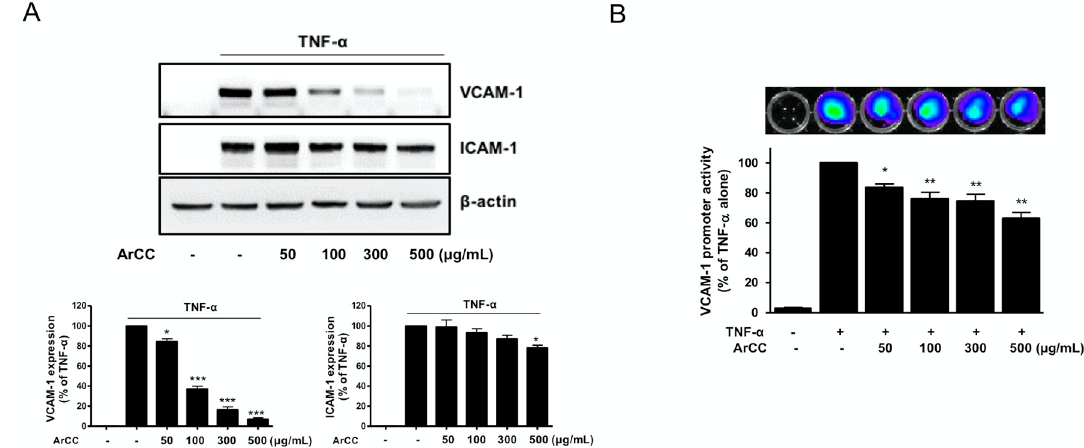
Figure 2. ArCC treatment suppresses adhesion molecule expression and transcriptional activation of vascular cell adhesion molecule-1 (VCAM-1) in TNF- α -stimulated human umbilical vein endothelial cells (HUVEC). ( A ) Immunoblotting for VCAM-1 and intercellular adhesion molecule-1 (ICAM-1) using lysates from tumor necrosis factor(TNF)- α -stimulated HUVECs treated with ArCC at the indicated concentrations. β -actin was used as the loading control. Relative changes in VCAM-1 (left) and ICAM-1 (right) expression levels were calculated based on densitometric scanning of each band. ( B ) Effects of ArCC on transcription of VCAM-1 were measured via luciferase reporter assay. Human embryonic kidney (HEK) 293T/VCAM-1-luc cells (4 × 10 4 cells/well) were plated in a black, 96-well plate, followed by treatment with various concentrations (0 to 500 µ g/mL) of ArCC, followed by stimulation with TNF- α for 6 h. The bioluminescent images were acquired following the addition of 150 µ g/mL D -luciferin substrate (upper). The luciferase activity, in units of total flux (p/s = photons/second) was quantified using an IVIS ® Lumina XRMS (X-ray multi-species optical imaging system) and analyzed by Living Image Software 4.4 (PerkinElmer) (lower). Values are expressed as mean ± SEM ( n = 3). * p < 0.05, ** p < 0.01, *** p < 0.001, compared with TNF- α -only, as calculated using one-way analysis of variance followed by Bonferroni’s multiple comparison tests.